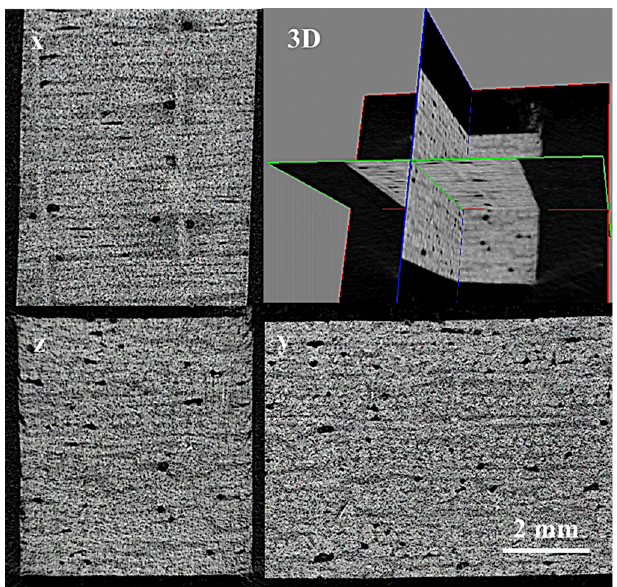
Figure 11. The 3D and cross section scanning images of the WA12W sample.